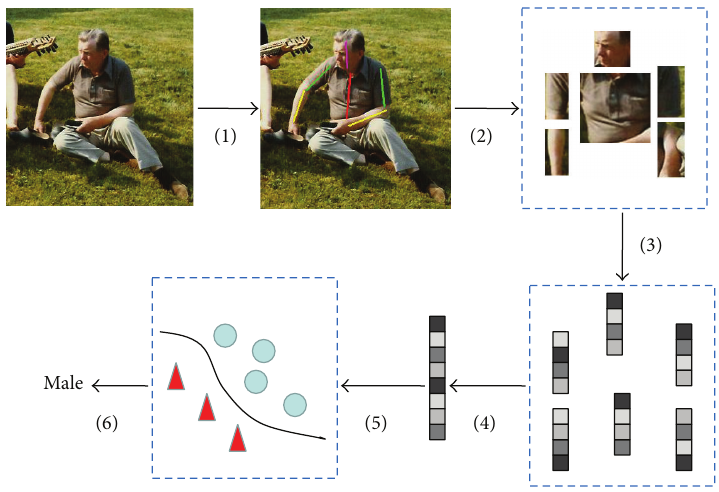
Figure 2: The proposed framework for gender recognition from articulated body.